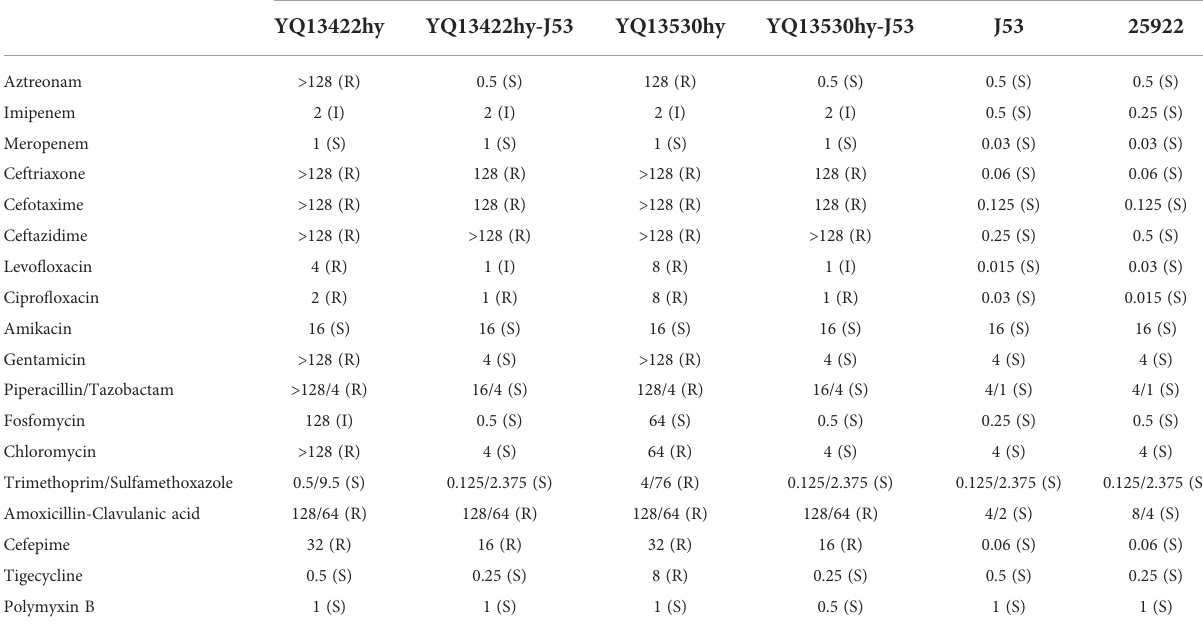
TABLE 1 MIC values of antimicrobials for E. hormaechei YQ13422hy andYQ13530hy, recipient strain J53, transconjugants YQ13422hy-J53 and YQ13530hy-J53, and control strain E. coli 25922.